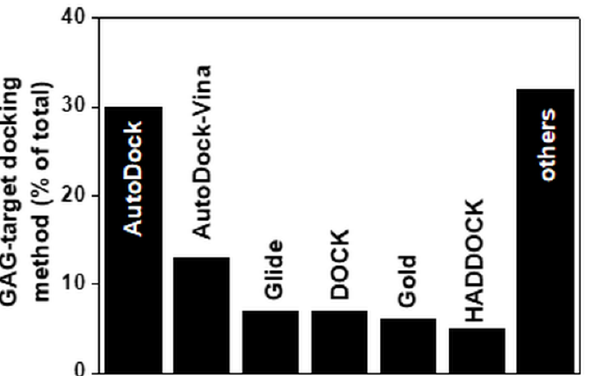
Figure 5. Docking software programs used to predict models of GAG complexes with their targets. Each bar reports the percentage of the published papers in which the indicated software programs were used. For the software programs grouped under “others”, see Table 2. For further details on the bibliographic research strategy, see Appendix A.